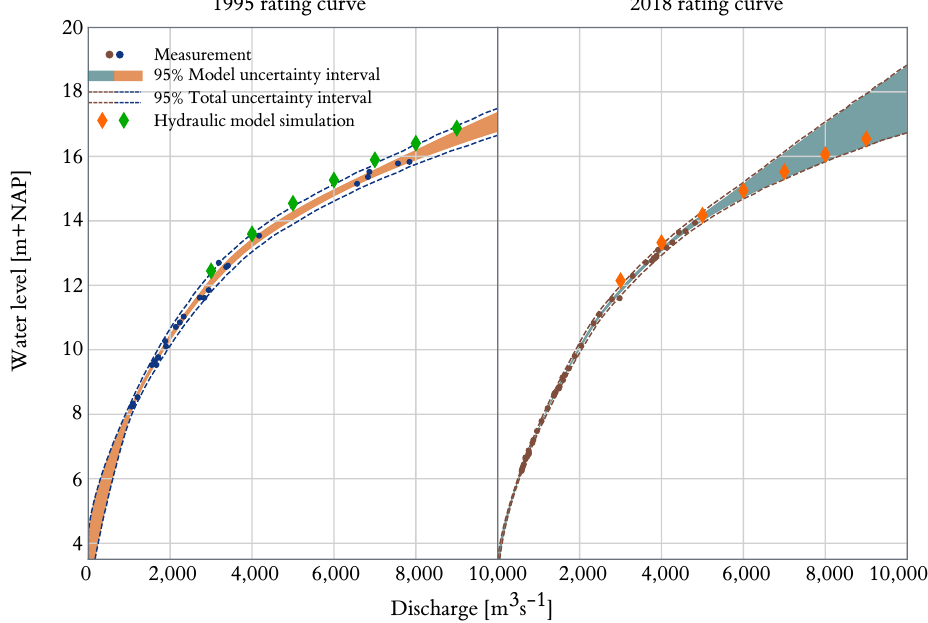
Figure 9. Comparing hydraulic model simulations with the rating curves for 1995 and 2018 shows that the model results fall within the uncertainty intervals of the rating curves. The decrease in water level due to human intervention may not be visible in the rating curves due to the uncertainty in